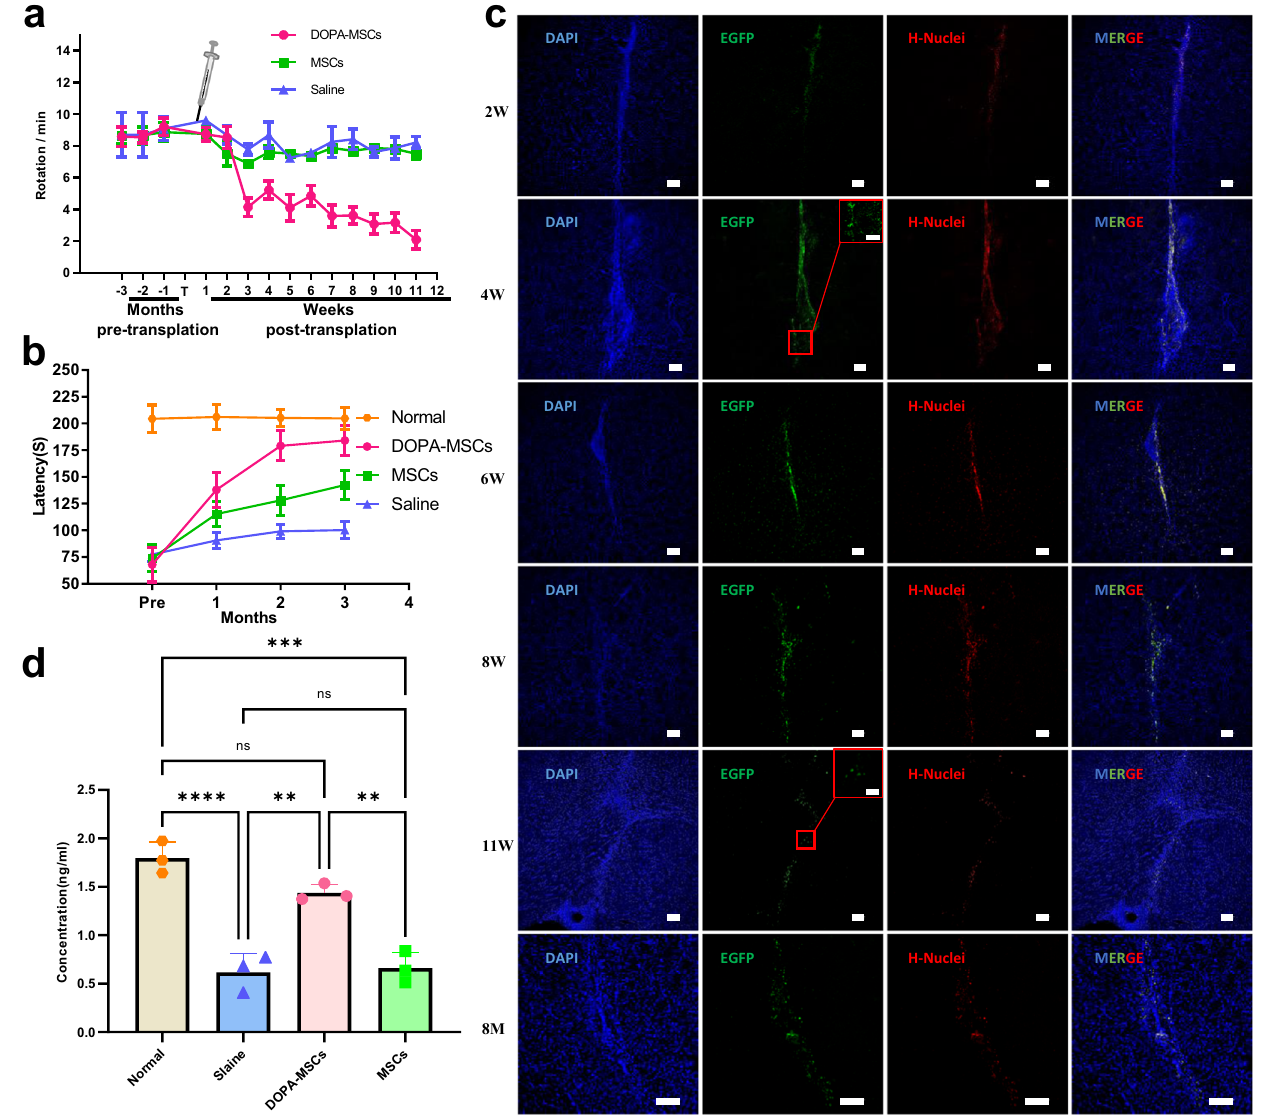
Fig. 2 DOPA-MSCs can survive long-term and reverse functional de fi cits in PD rats after transplantation. a and b Behavioral analysis. a Apomorphine-induced rotation analysis in the three groups grafted with DOPA-MSCs ( n = 13), MSCs ( n = 3), or PBS ( n = 3). b The rotarod test showing the changes in latency time to fall in PD rats before and after transplantation. The results are expressed as the time (second) that rats remained on an accelerating rotarod before falling. Data are presented as the mean ± SEM. In the two behavioral tests, Two-way ANOVA was followed by Holm – Sidak test. c Immuno fl uorescence staining for grafts placed in the striatum of 6-OHDA lesioned rats after 1, 2, 4, 6, 7, 11 weeks, and 8 months. EGFP + , H-Nuclei + . Double-staining of EGFP + and H-Nuclei + indicated that these cells were derived from grafted DOPA-MSCs. Scale bars: 100, 50 μ m in the zoom panel. H-Nuclei, human nuclei; EGFP, Enhanced Green Fluorescent Protein. d Dopamine concentration in cerebrospinal fl uid from three different treated rats 3 months after transplantation. Data are presented as the mean ± SEM. One-way AONVA analysis of variance was used to compare the differences between groups, and signi fi cant differences were evaluated by the Bonferroni test (** p < 0.01, *** p <